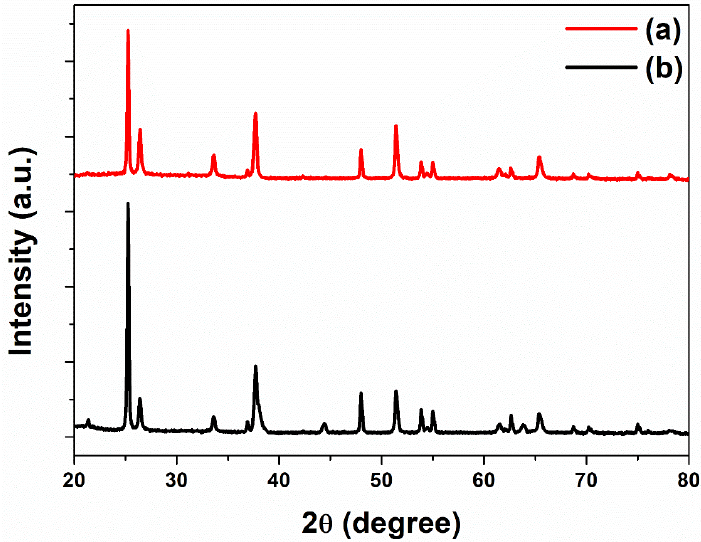
Figure 3. X-ray diffraction (XRD) data for: (a) f-TNTAs and (b) f-TNTAs with Au NPs.